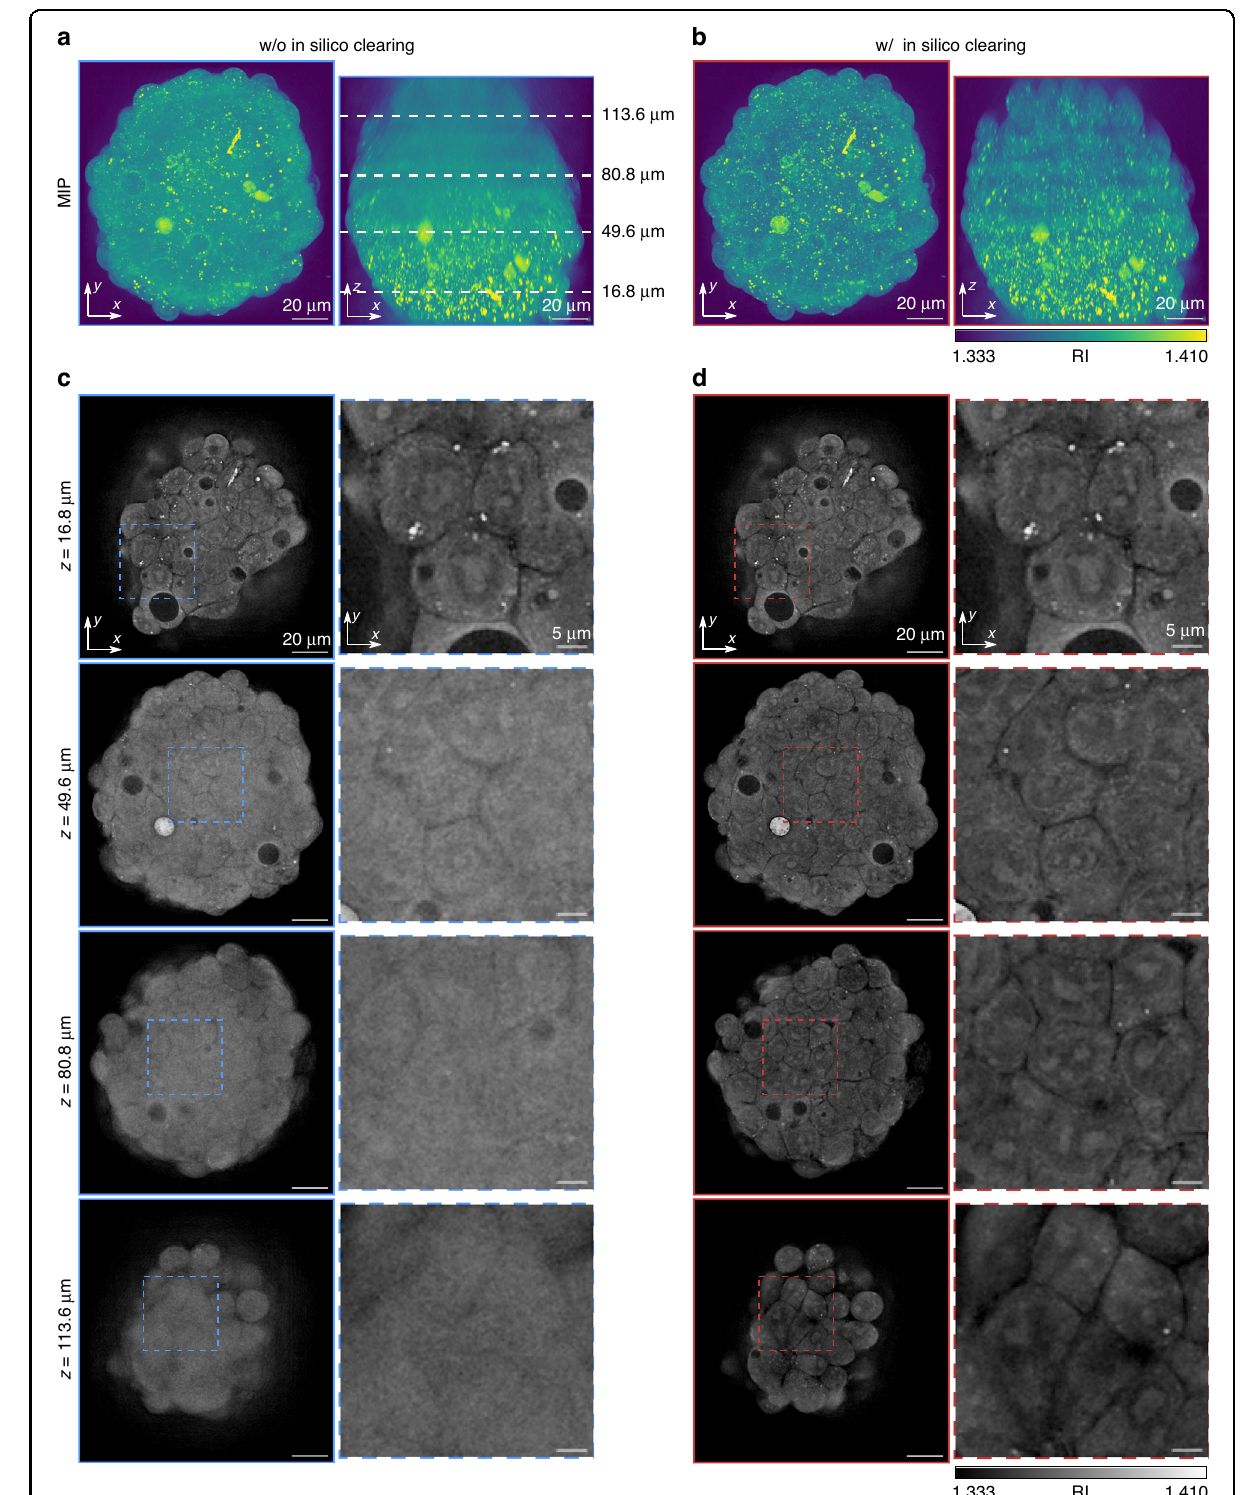
Fig. 3 Experimental validation of in-silico clearing RI tomography using a human hepatocyte spheroid. Maximum intensity projection of the RI map reconstructed by ( a ) the case without in-silico clearing and ( b ) with in-silico clearing. c, d Cross-sections of the RI maps at different z locations (identi fi ed by white dashed lines in a ). The movie showing all cross-sections is provided in Supplementary Video